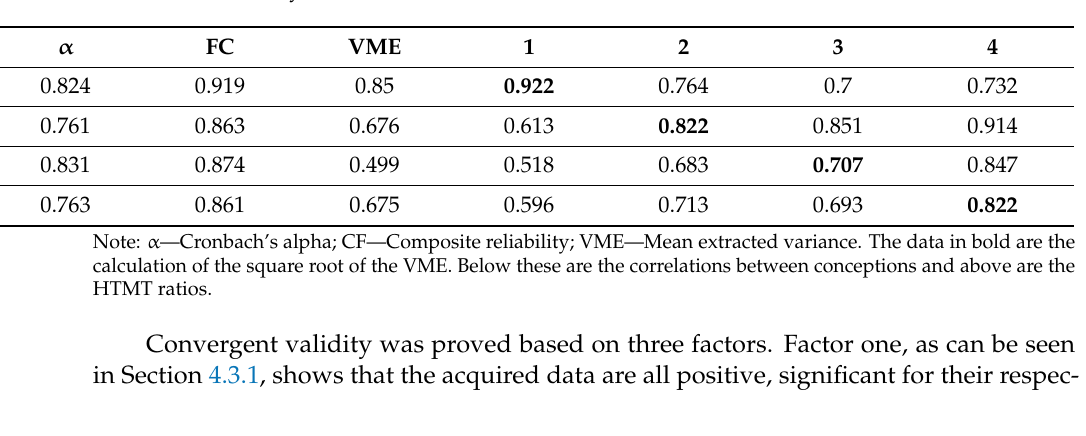
Table 2. Verification of composite reliability (CF), mean extracted variance (MEV), correlations and, discriminant